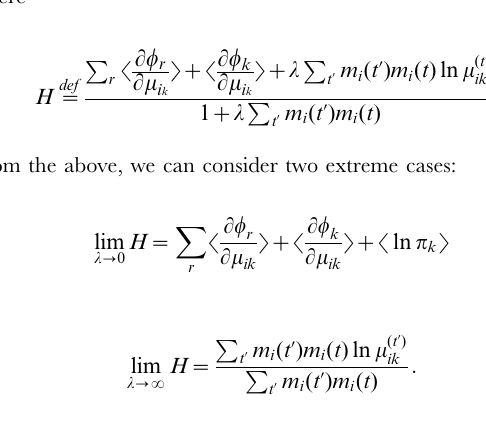
Overall algorithm. Starting from a randomly initialized m ik for all i [ V and k [ C , we update the tree parameters according